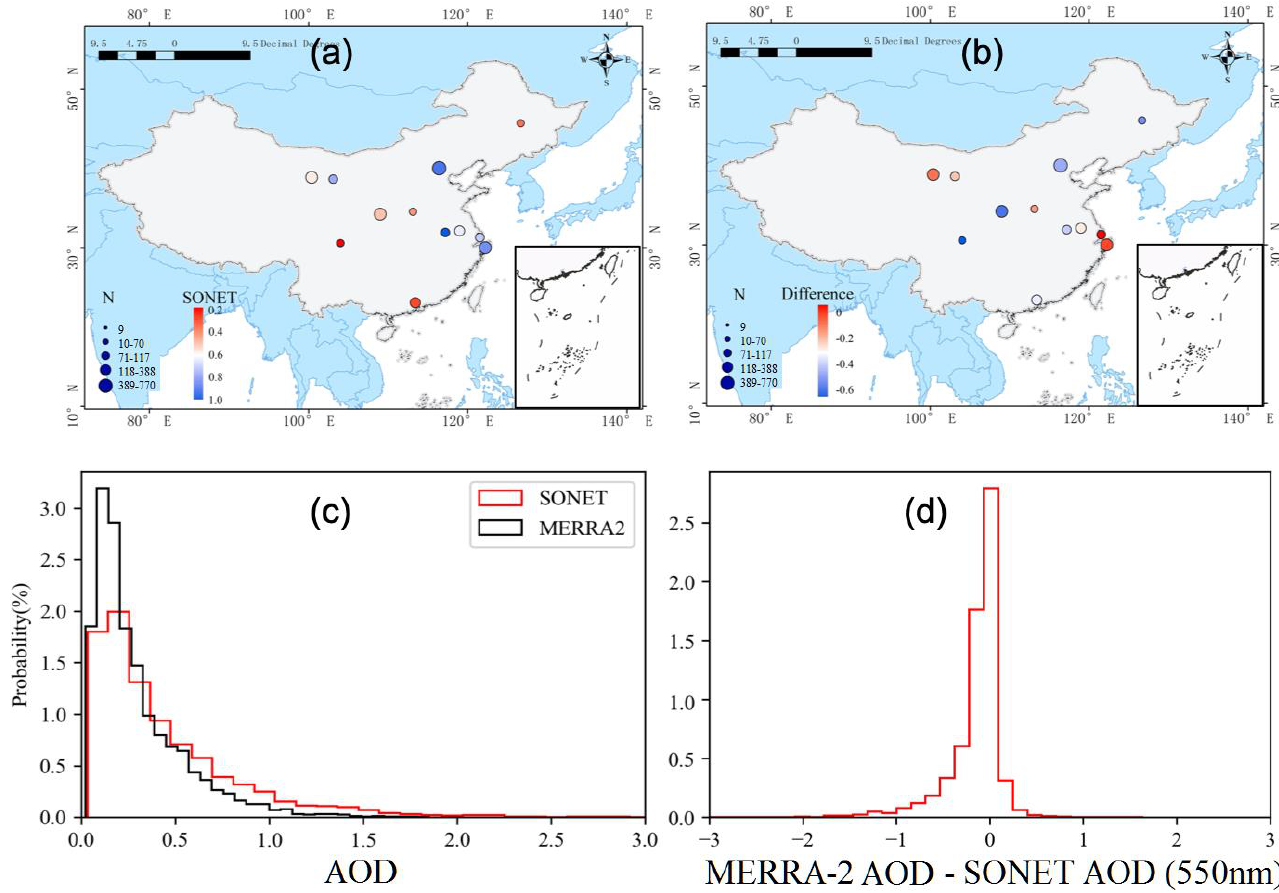
Figure 3. ( a ) The statistics mean of the AOD (550 nm) at 12 SONET sites over China from January 2011 to December 2013. ( b ) The differences of MERRA-2 and SONET AOD (550 nm) from 2011 to 2013. Color represents the values and circle size represents the numbers of matched points. ( c ) The probability density functions (PDFs) of the MERRA-2 and SONET AOD (550 nm). ( d ) PDF for AOD (550 nm) difference (AOD MERRA-2 –AOD SONET ) between MERRA-2 and